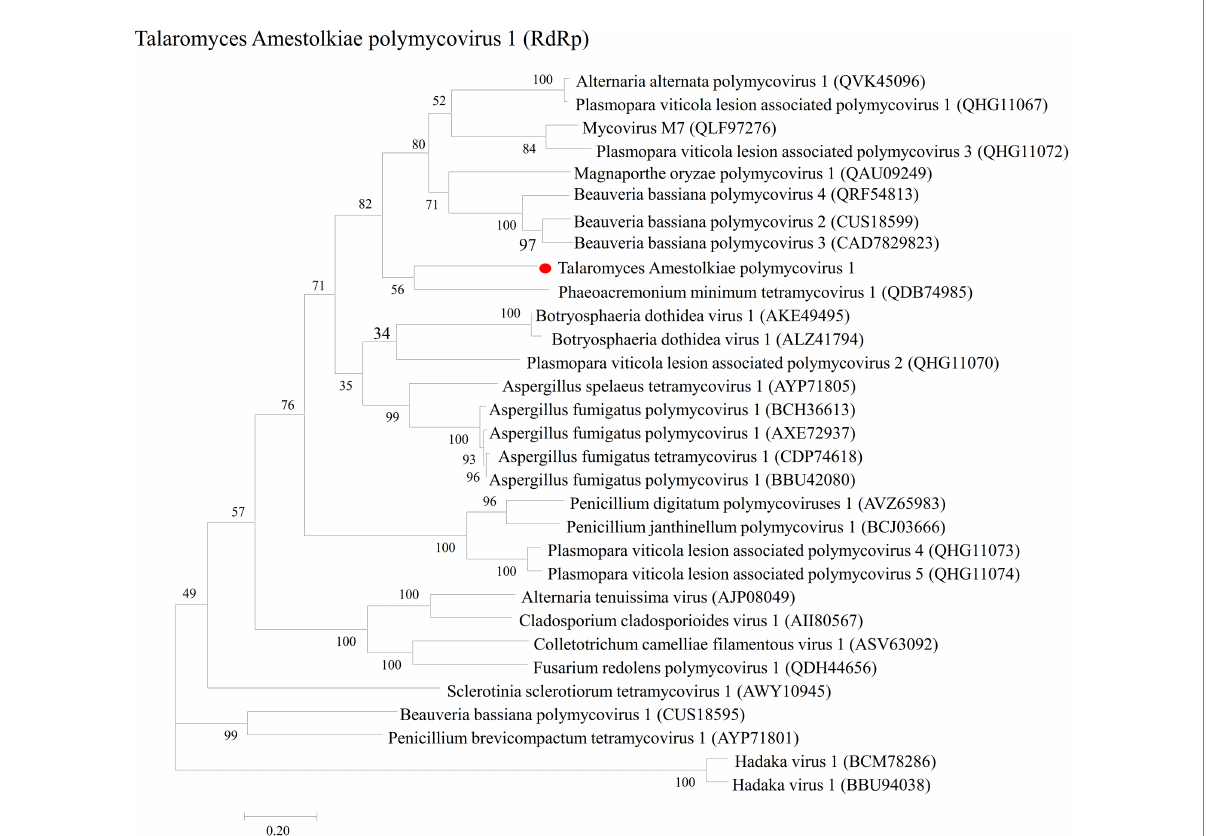
FIGURE 2 Phylogenetic analyses of TaPmV-1 and selected polymycoviruses. Phylogenetic analyses of TaPmV-l based on the sequences of